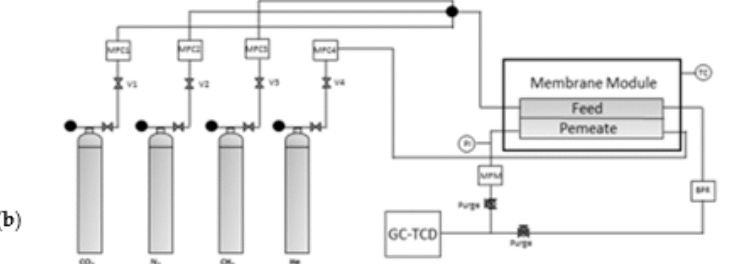
Figure A1. ( a ) Pure gas permeation unit (V1, V4 = inlet; V2, V3 = outlet) and ( b ) gas mixtures set-up (V = valve, MFC = mass flow controller, MFM = mass flow meter, TC = temperature controller, PI = pressure indicator, BPR = back pressure regulator, GC = gas chromatographer with TCD detector).